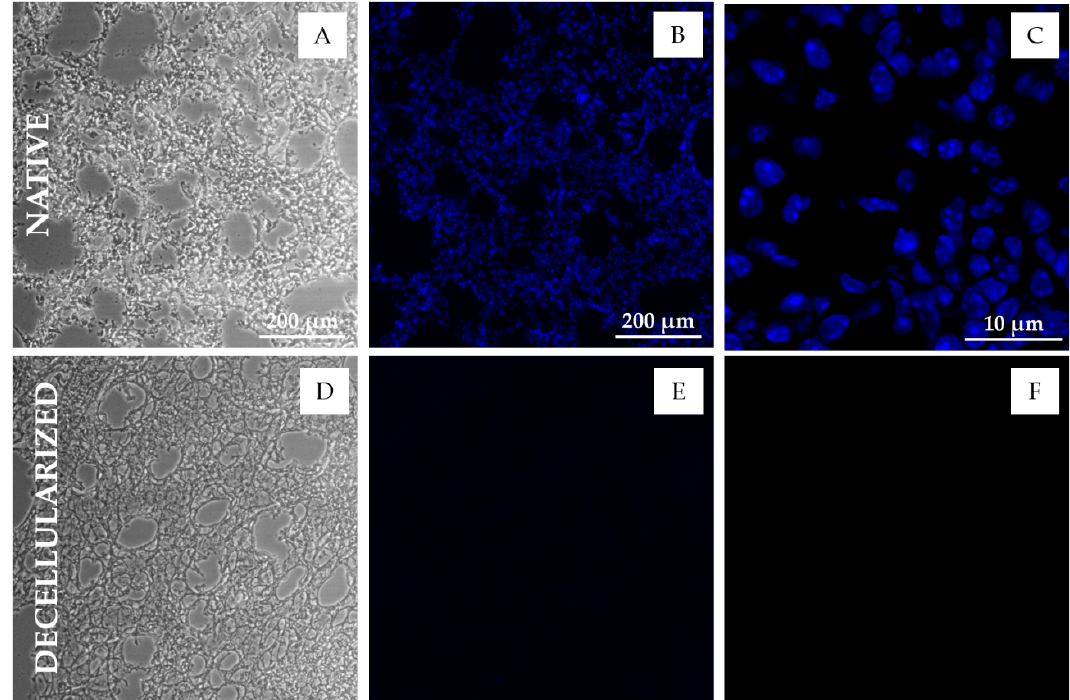
Figure 3. Microscopic images of lung tissue sections before and after decellularization. ( A – C ) PC image ( A ), DNA-stained fluorescent image ( B ) and confocal image ( C ) of native mice lung tissue sections (20 µm); ( D – F ) PC image ( D ), DNA-stained fluorescent image ( E ) and confocal image( F ) of decellularized mice lung tissue sections (20 µm). Epifluorescent images were taken using a 10× objective. Confocal images were taken using a 60× oil immersion objective. DNA was stained by Hoechst 33342. Absence of nuclei and DNA is apparent in the decellularized sections ( E , F ).